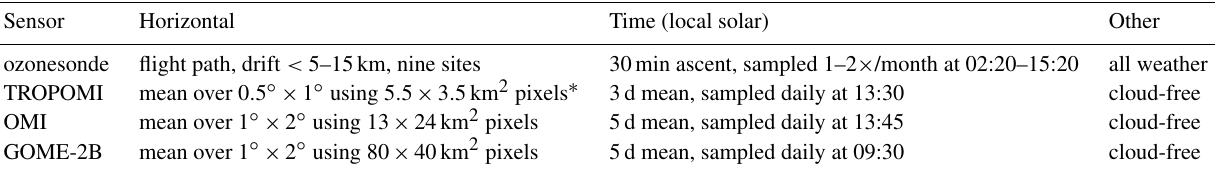
Table 1. Sampling and smoothing properties of tropical tropospheric ozone column data records (surface–270hPa, 20 ◦ S–20 ◦ N). The second column displays latitude by longitude for the tropospheric column, as well as pixel footprint (along track by across track) at nadir of the total ozone columns used by the CCD algorithm. Data records are ordered by smoothing